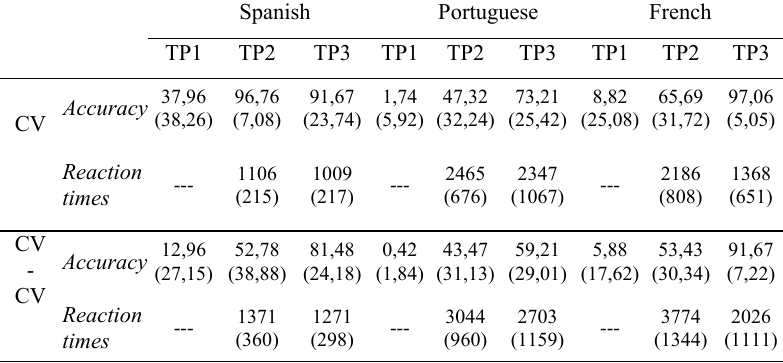
Table V. Mean percentage of correct responses, mean reaction time (ms) for CV and CVCV pseudoword reading in Spanish, Portuguese and French at TP1 (October), TP2 (February-March) and TP3 (May-June). Standard deviations in parentheses. Spanish Portuguese